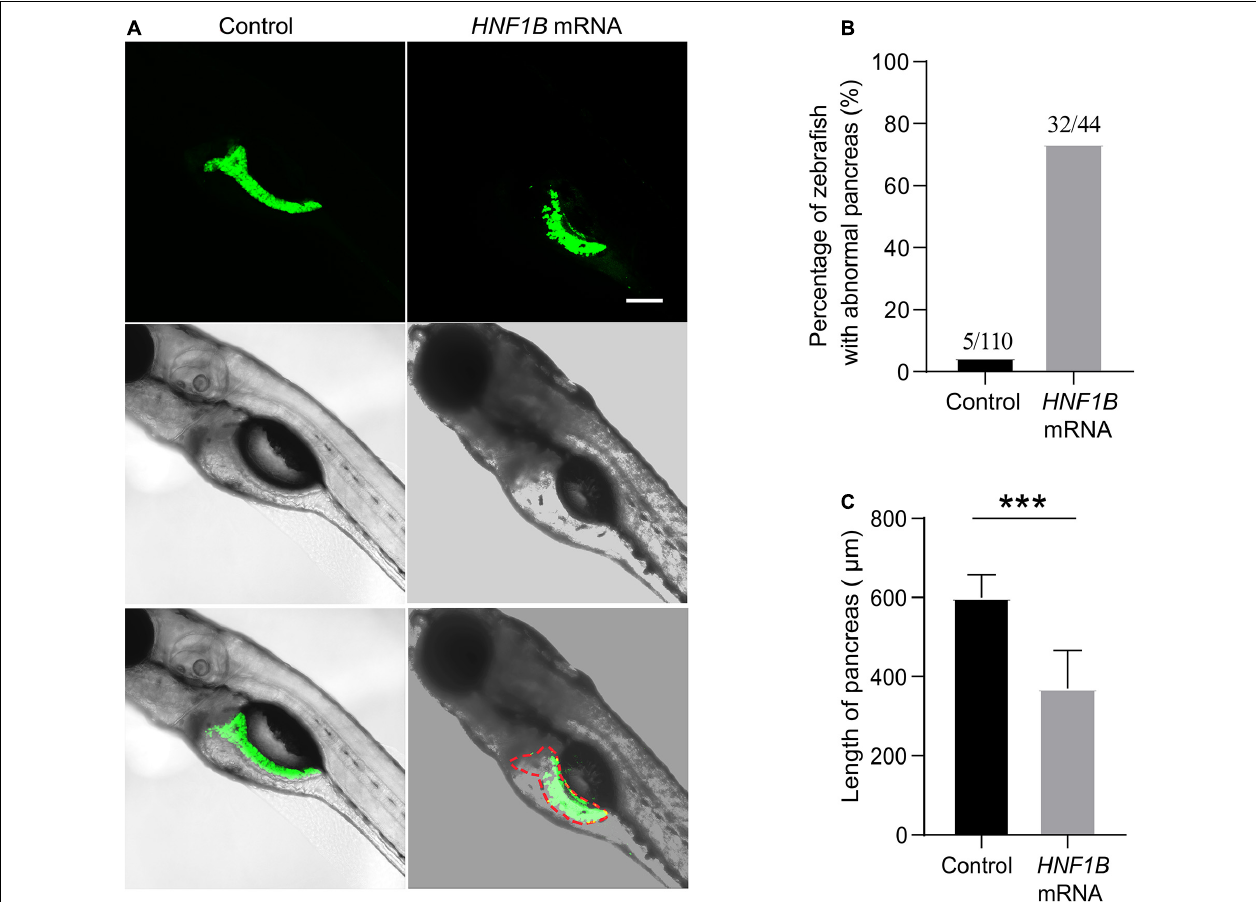
FIGURE 3 | (A) Different features of zebrafish in the HNF1B overexpression group and the control group. (B) The ratio of zebrafish with abnormal pancreas in the HNF1B overexpression group and the control group. (C) The length of the pancreas in the HNF1B overexpression group and the control